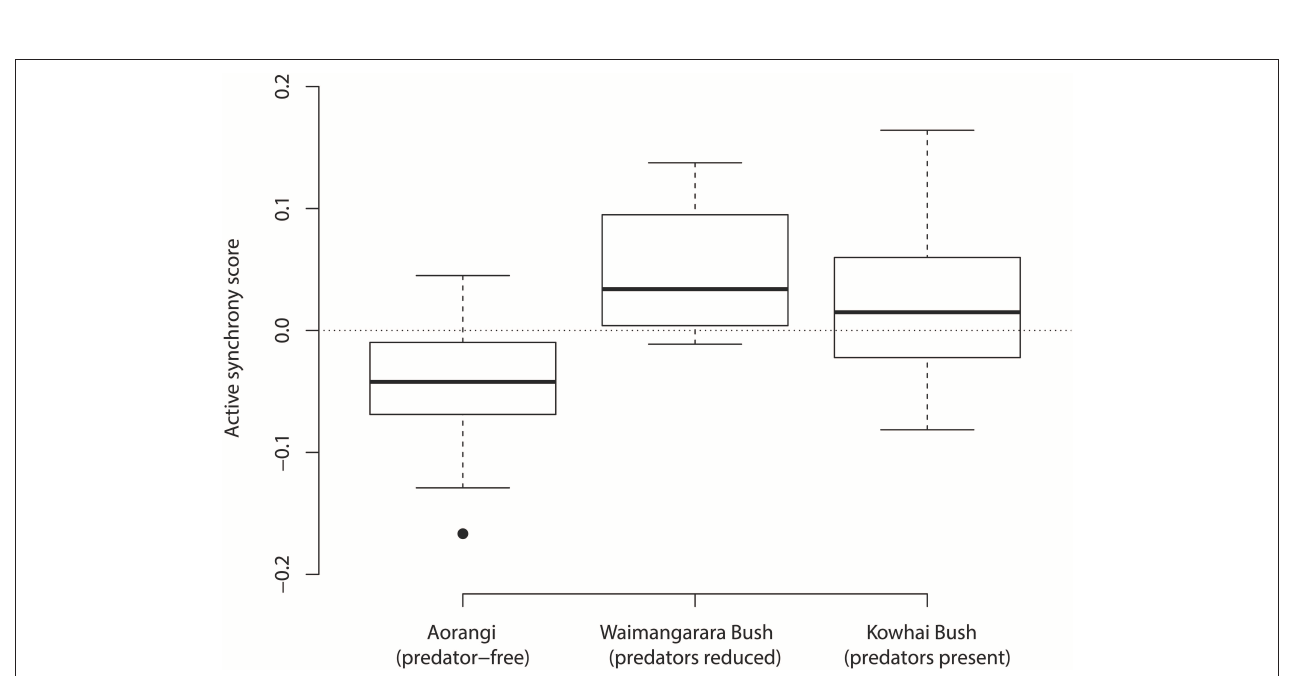
FIGURE 3 | The distribution of synchrony scores from bellbird ( Anthornis melanura ) nest watches at three sites in New Zealand; these are observed proportions of visits that occurred within 120s of the previous, minus the median (“expected”) proportion from 100 simulated nest watches with the same visit rate. Aorangi is an island to which predatory mammals have never been introduced. Numbers of predatory mammals at Waimangarara Bush were reduced by trapping during the study period. Predatory mammals were present and not trapped at Kowhai Bush.